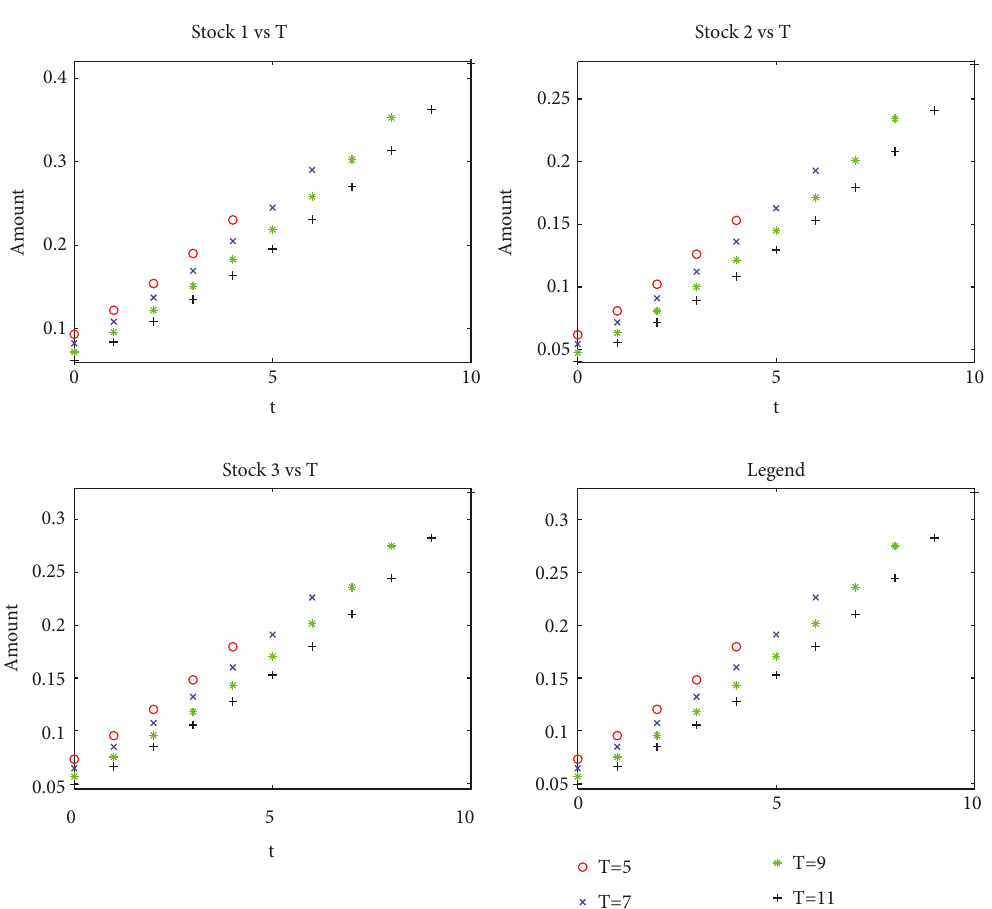
Figure 3: Equilibrium strategy under different investment time